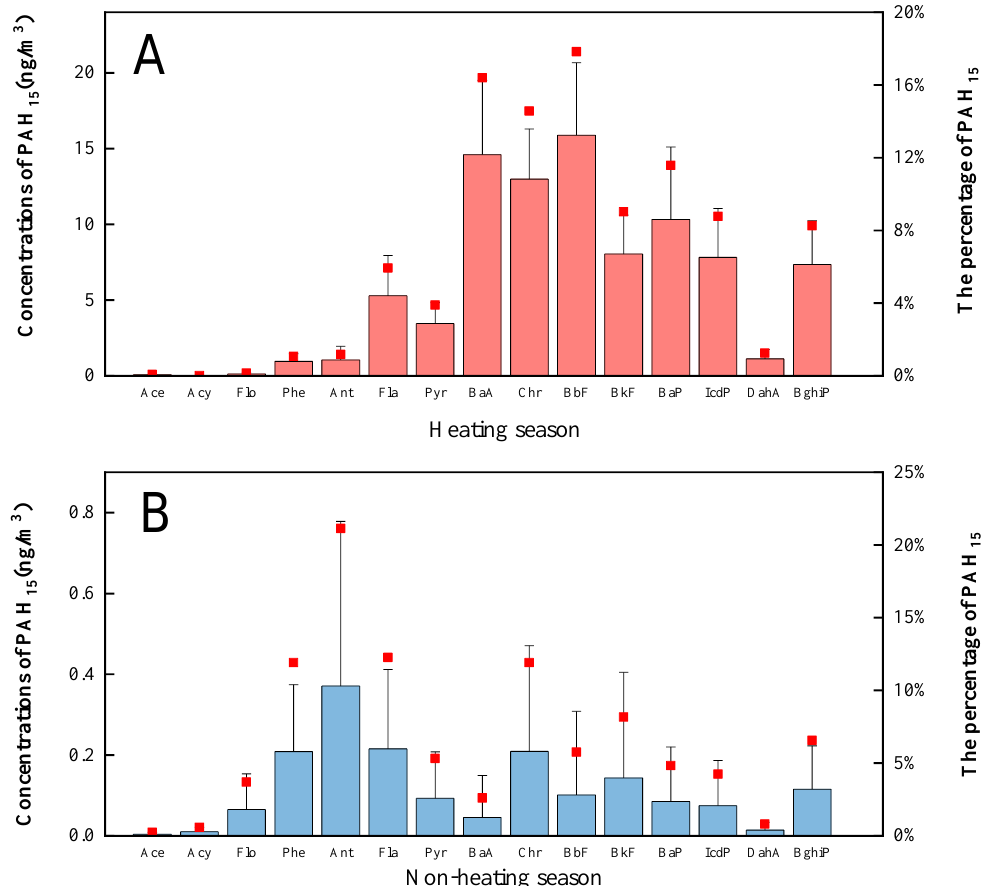
Figure 2. Comparison of the average concentration of individual polycyclic aromatic hydrocarbon congeners in the heating and non-heating seasons. The red squares represent the proportion of each PAH congener in 15 PAHs.